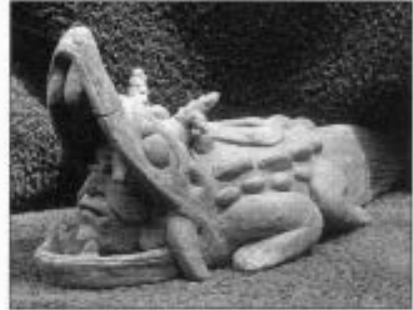
Figure 9 One of the crocodile effigy ves­ sels found at Lamanai. A man's head is emerging from the creature's